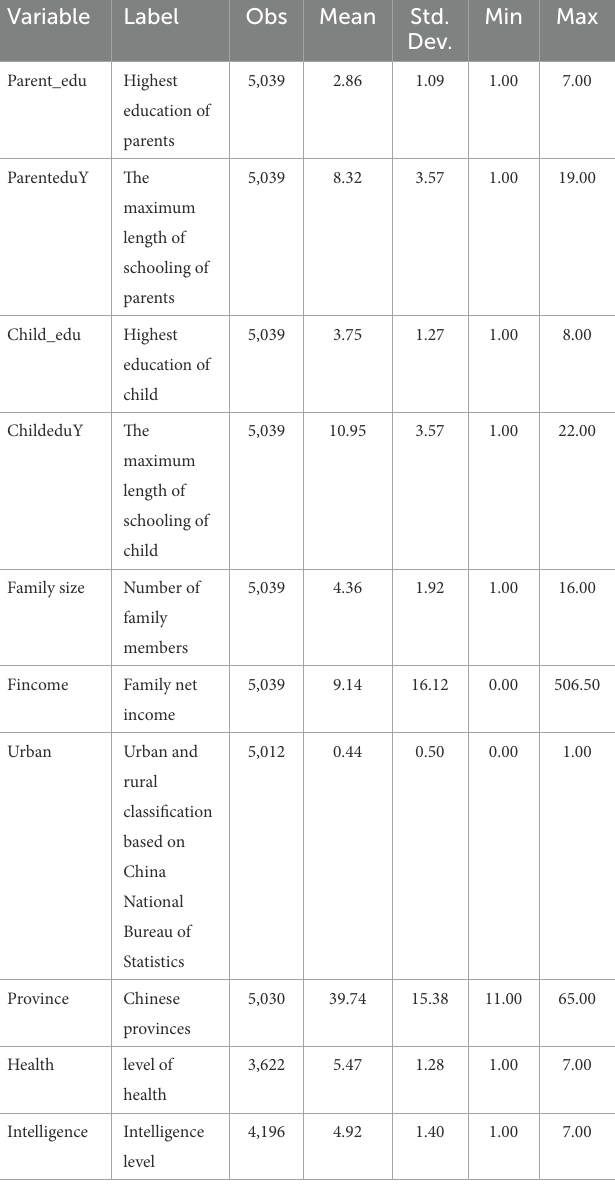
TABLE 1 Descriptive statistics of the